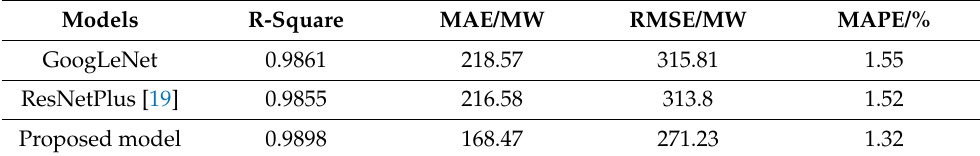
Table 2. Yearly R-Square, MAE, RMSE, and MAPE of proposed model compared with basic model. Models